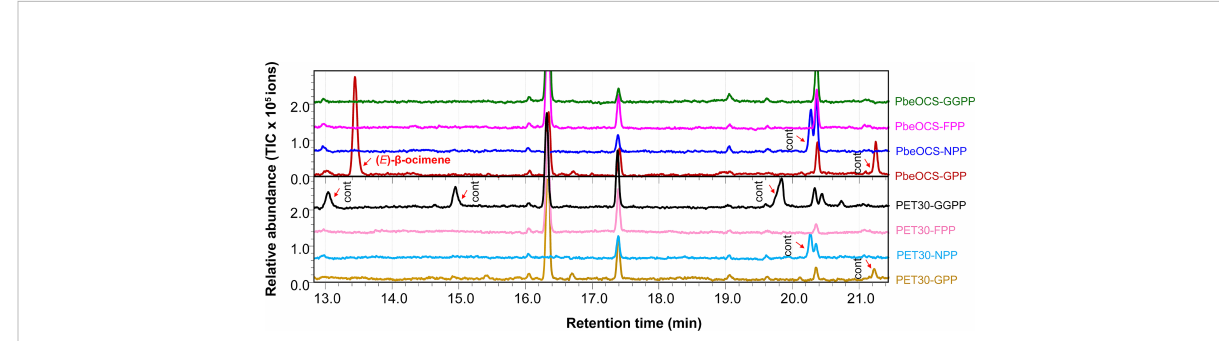
FIGURE 5 In vitro enzymatic assays of recombinant PbeOCS using different substrates. Cont, contamination.